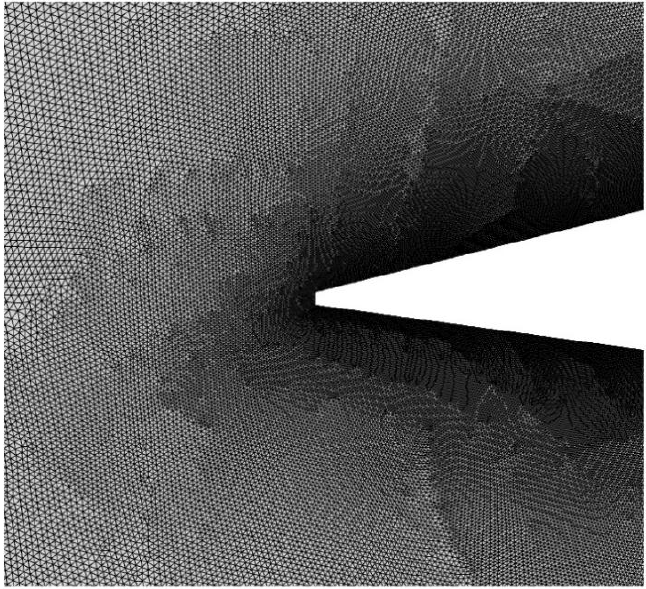
Figure 14. Truncated cone mesh (part).